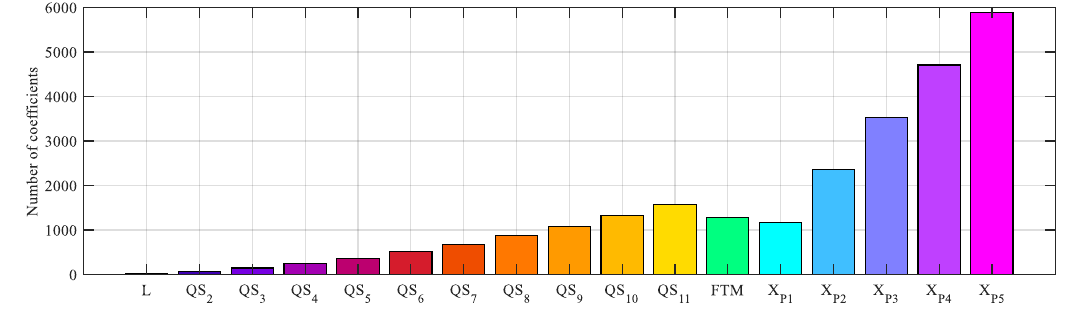
Figure 3. NRMSE mean value and 95th percentile values for each considered model.